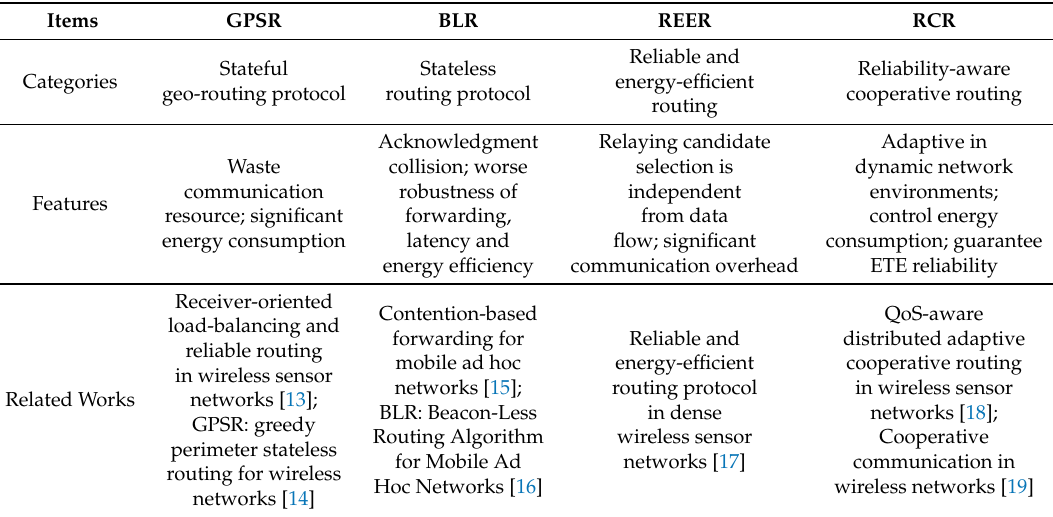
Table 2. Comparison of greedy perimeter stateless routing (GPSR), beaconless routing schemes (BLR), reliable and energy-efficient routing (REER) and